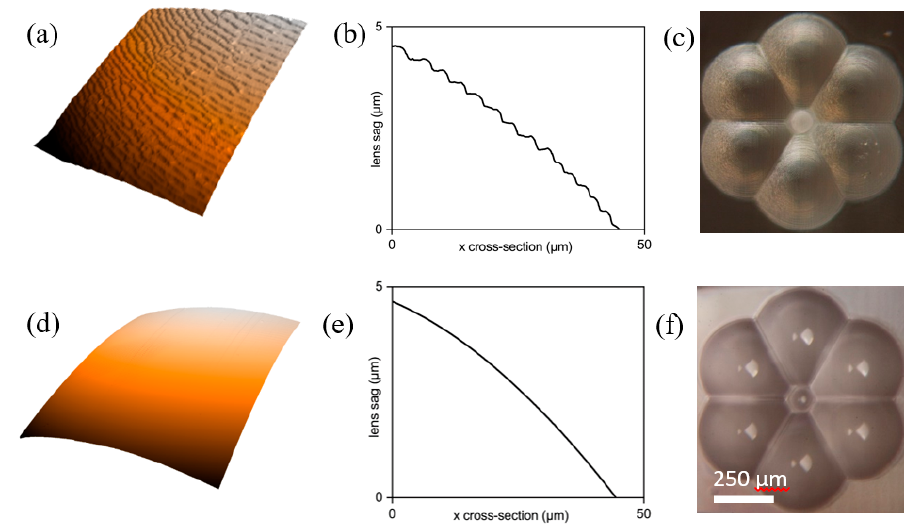
Figure 4. Example lens profiles measured before and after flame polishing using an atomic force microscope (AFM). ( a – c ) Shows a 3D colour plot, 2D surface profile, and micrograph, respectively before flame polishing. ( d – f ) Shows the same plots made after flame polishing for 0.25 s. The colour maps in ( a , d ) were measured over 50 µ m × 50 µ m areas. The arithmetic roughness, R a , was reduced from 48.7 to 2.26 nm.